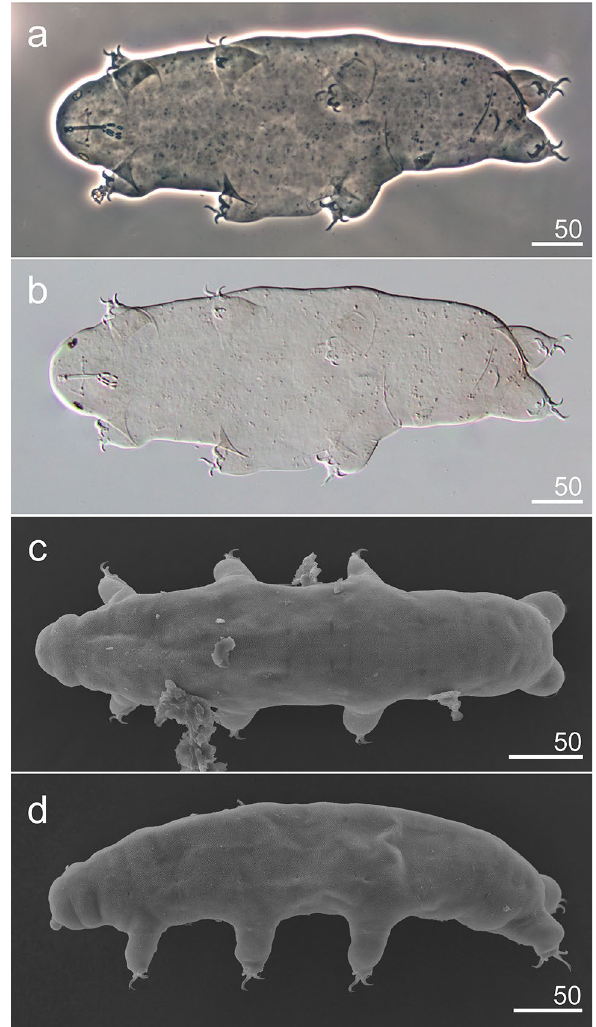
Figure 3. Hypsibius nivalis sp. nov., habitus: ( a ) ventrolateral view, holotype (PCM), ( b ) ventrolateral view, holotype (DIC), ( c ) dorsal view, paratype (SEM), ( d ) lateral view, paratype